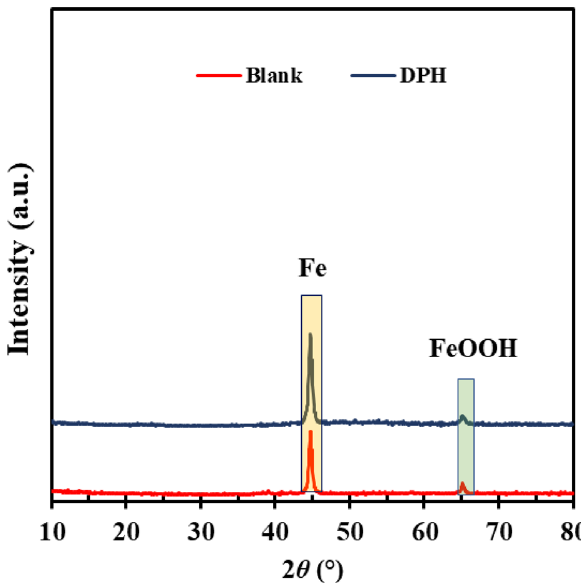
Figure 10. GIXRD spectra of the MS surface submerged in 1 M HCl solution without and with 1000 ppm DPH after 4